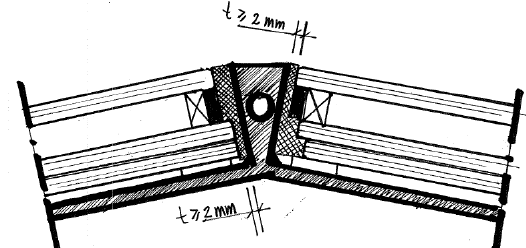
Figure 9: Adaptation of POM strips to adjust deviations from the theoretic shape